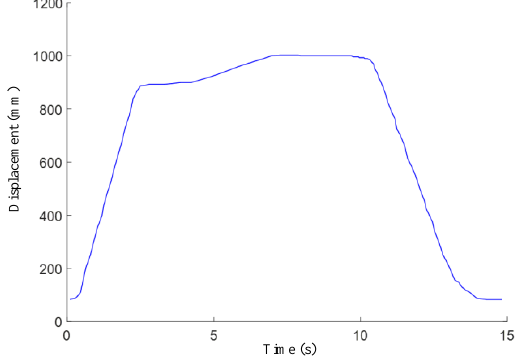
Table 1. The data used in the case.